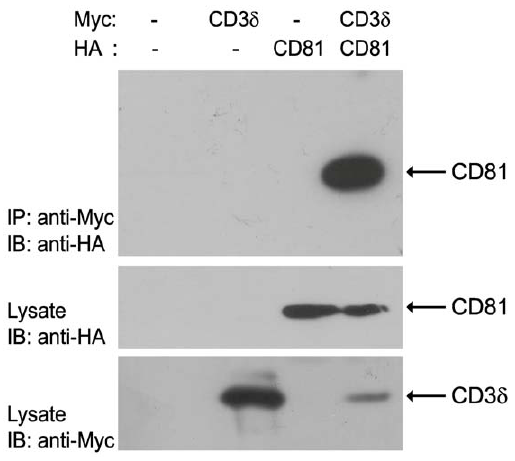
Figure 1. CD81 interacts with CD3 d . HEK293T cells were transfected with plasmids encoding CD81 protein in the presence (lane 4) or absence of CD3 d (lanes 3). Top row: Lysates from untransfected HEK293T cells (lane 1) or transfected cells (lanes 2–4) were immuno- precipitated with anti-Myc antibodies and immunoblotted with anti-HA antibodies. Anti-HA immunoblot shows the presence of a 26 kD band corresponding to the CD81 protein co-immunoprecipitated with Myc- CD3 d protein. Middle row: anti-HA immunoblot of lysates demonstrates the expression of CD81 specifically in cells transfected with this construct (lane 3–4). Bottom row: anti-Myc immunoblot of lysates demonstrates the expression of CD3 d in lanes 2 and 4.